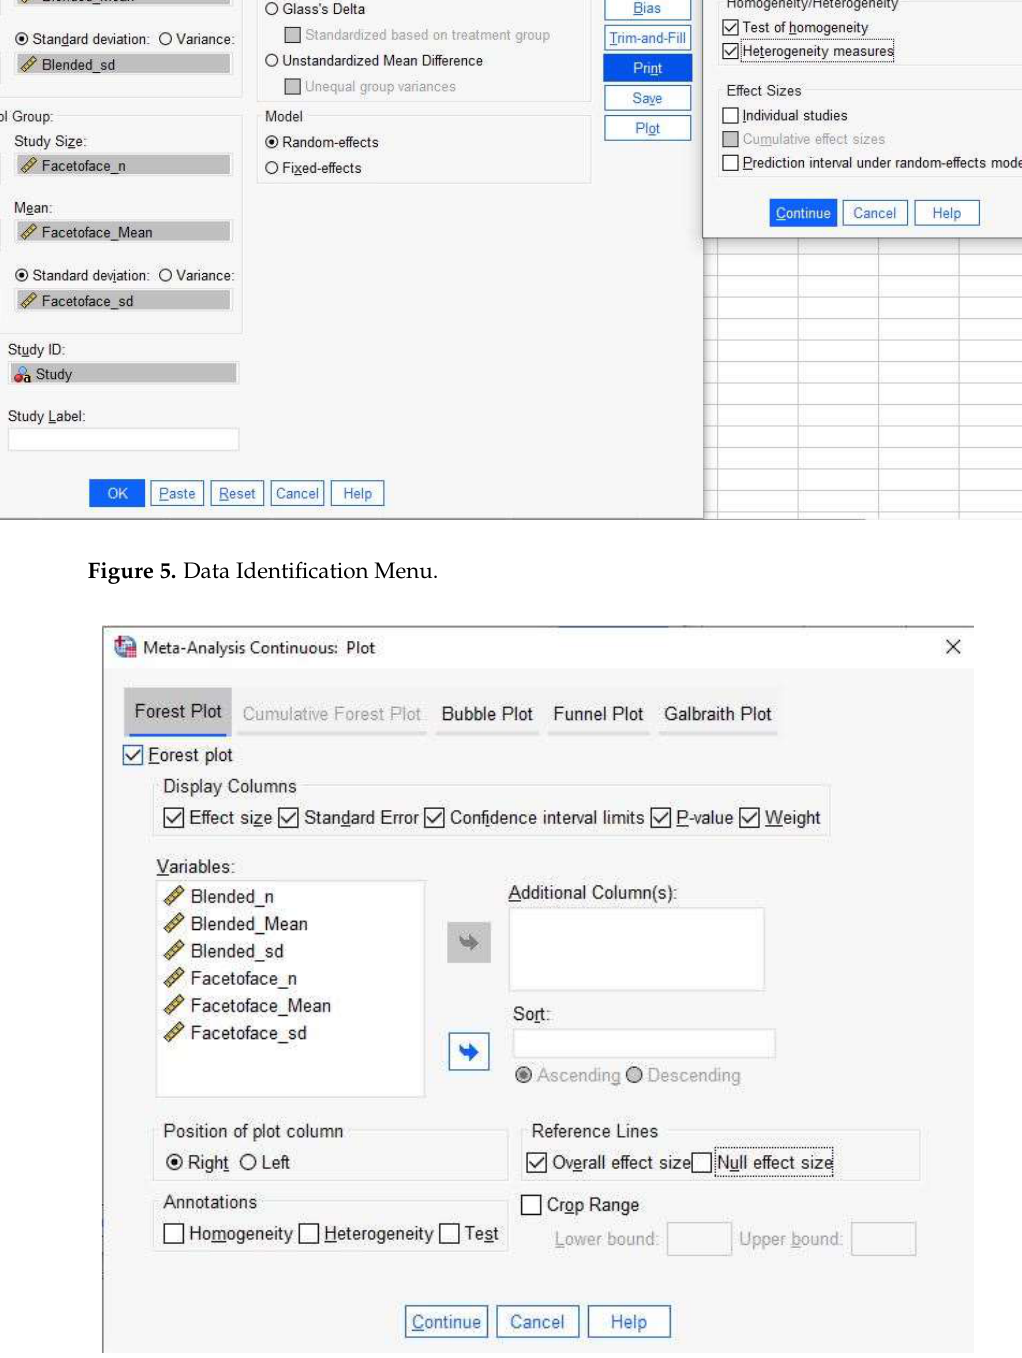
Figure 6. Forrest Plot Menu.